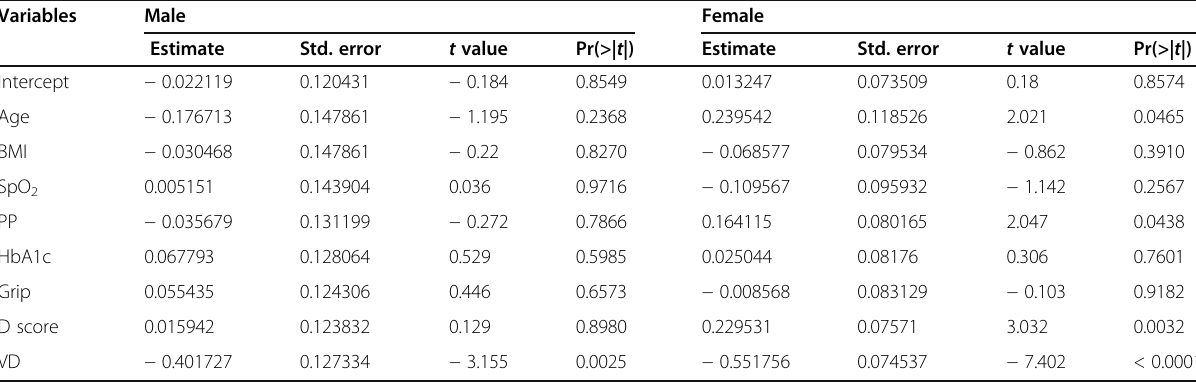
Table 4 Results of the multiple regression analysis with Hb as the objective variable. Only vascular diameter was found to be significantly correlated with the Hb value in males. In females, age, pulse pressure, vascular diameter, and deprivation score were strongly correlated with the Hb value Variables Male Female Estimate Std. error t value Pr(>| t |) Estimate Std. error